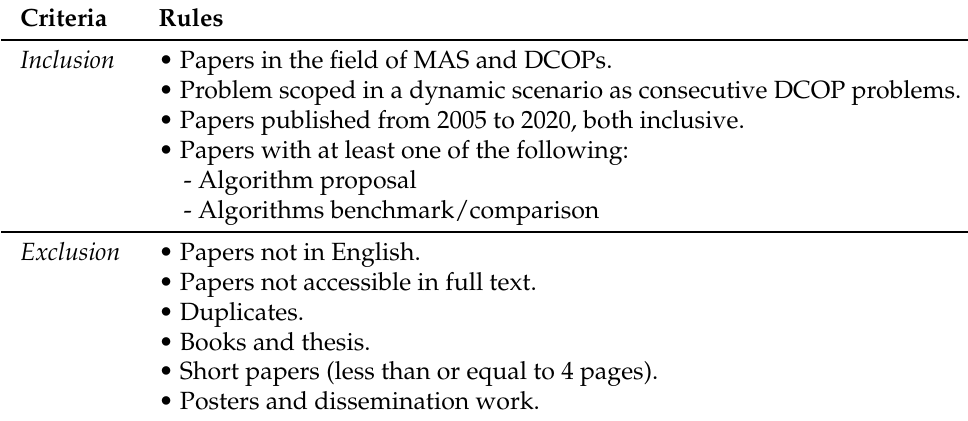
Table 2. Summary of the inclusion and exclusion criteria.